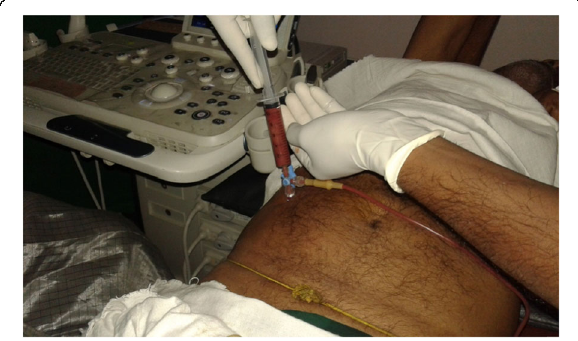
Fig. 3 Therapeutic ultrasonographic-guided percutaneous aspiration of ALA in the right-upper quadrant at THJ — a relatively safe bedside